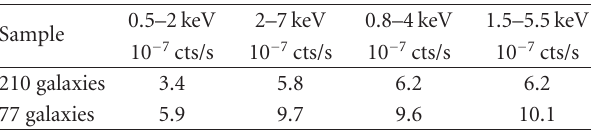
Table 1: 3 σ count rates upper